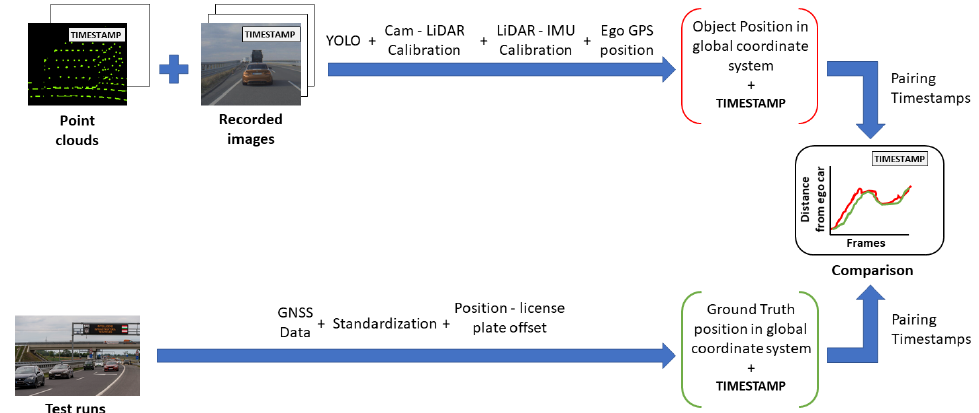
Figure 37. The evaluation process of fusion-based object distance from ego vehicle with ground truth data.